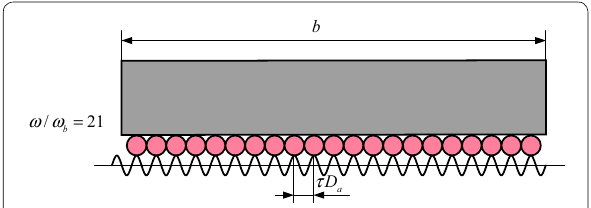
Figure 7 Relationship between the number of rollers and the guideway error with ω/ω b = 21